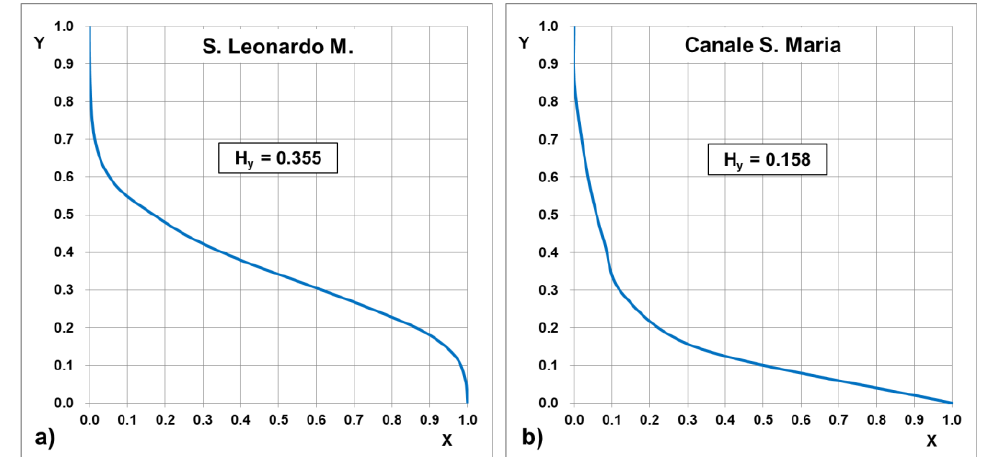
Figure 2. Example of hypsometric curves derived from QMorphoStream. ( a ) The S. Leonardo M. catchment shows the typical S-shaped curve and hypsometric integral of a basin at a “mature” stage of morphological evolution; ( b ) the upward concave curve and the low value of the integral of the Canale S. Maria catchment indicate a typical “senile” stage of morphological evolution.